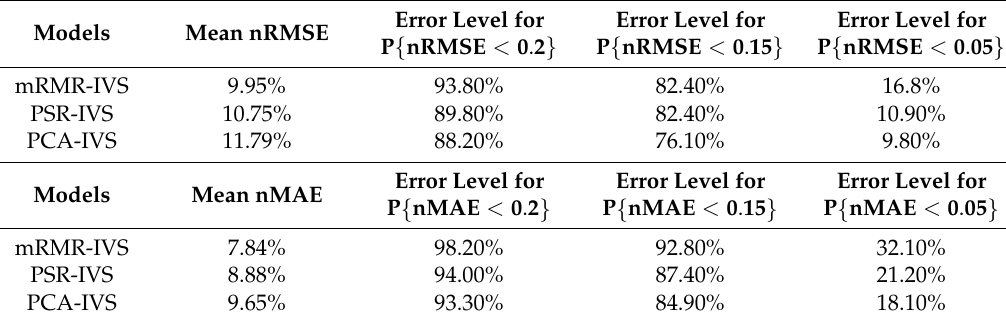
Table 6. Mean errors and probability distributions of Anzishan farm.